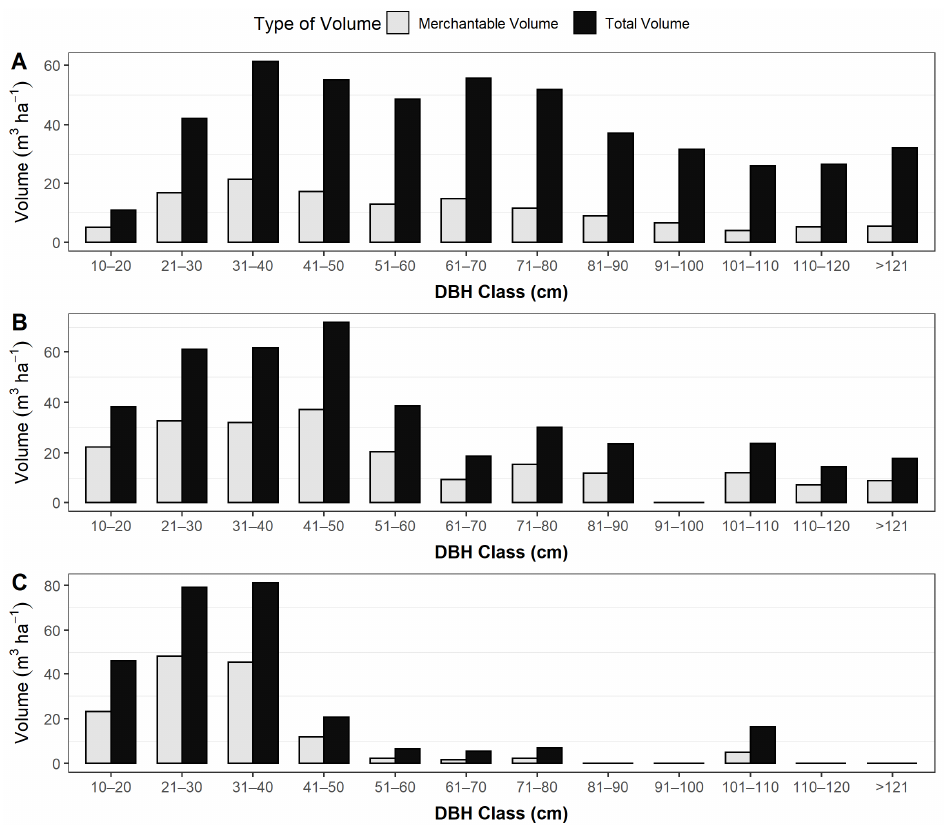
Figure 3. Total and merchantable volume (m 3 ha − 1 ) per diameter class of trees found in ( A ) logged forests (temporary plots), ( B ) logged forests (permanent research plot) and ( C ) mixed-species plantations.